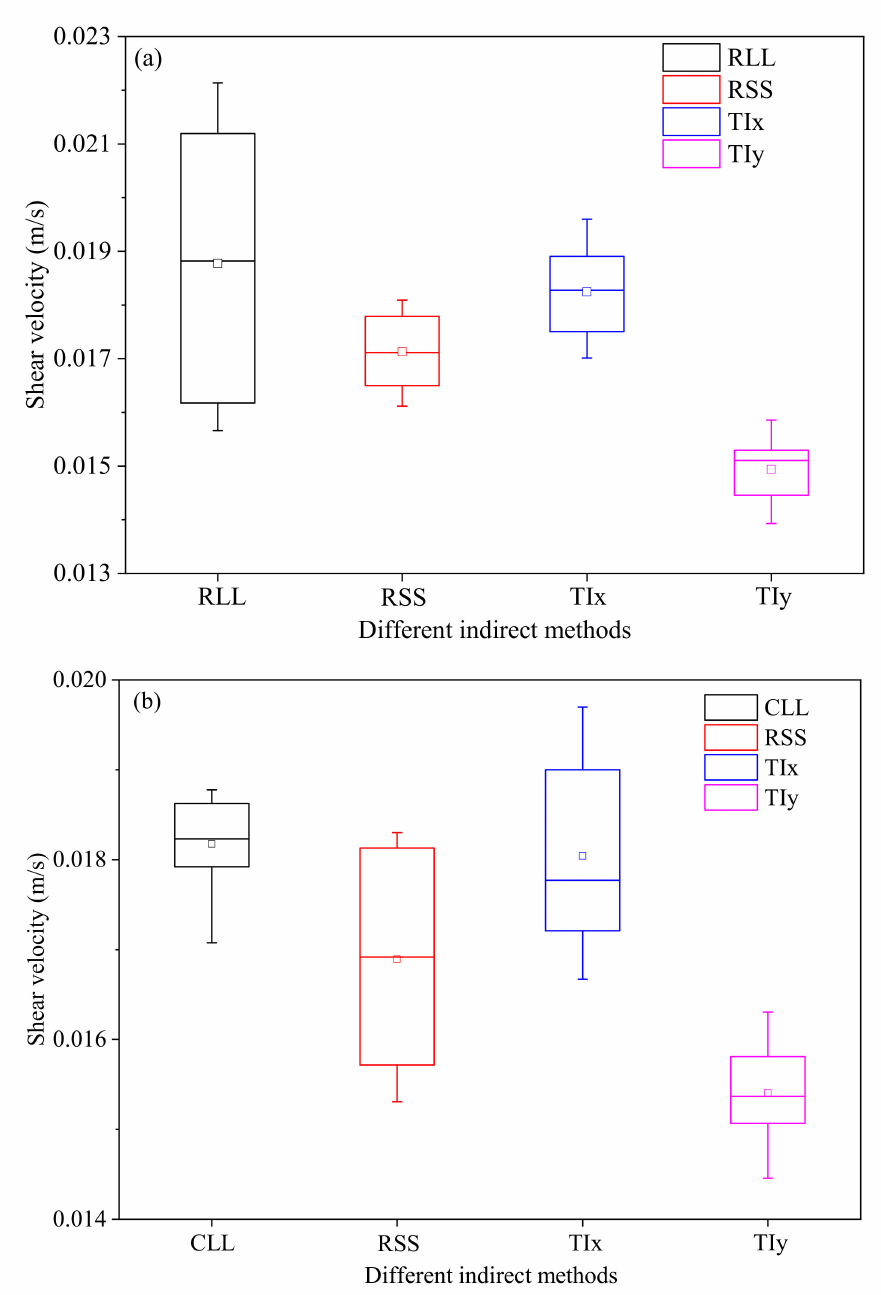
Figure 7. Shear velocity estimated by different indirect methods: ( a ) sand zone; and ( b ) smooth zone. The corresponding bed shear stresses acting on the sand zone and smooth zone of the close conduit are shown in Figure